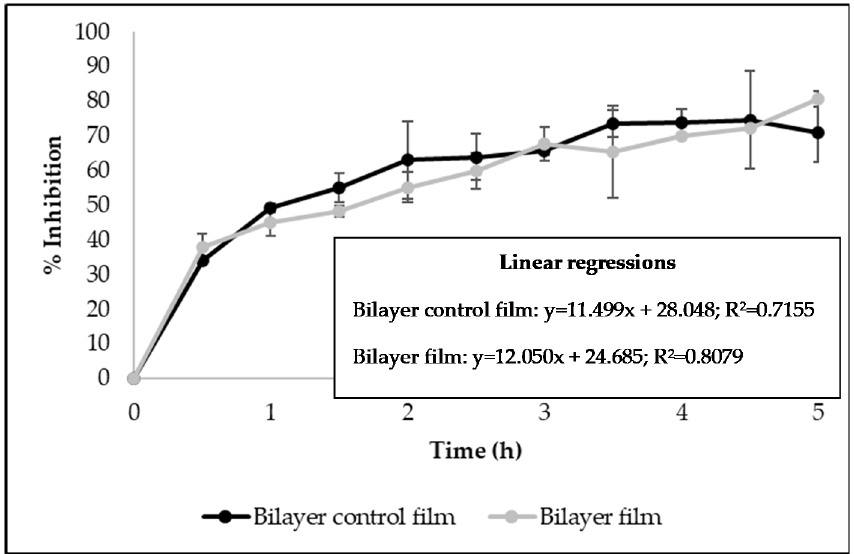
Figure 3. Antioxidant activity of bilayer films measured by DPPH free radical scavenging assay (Results expressed as mean ± SD).